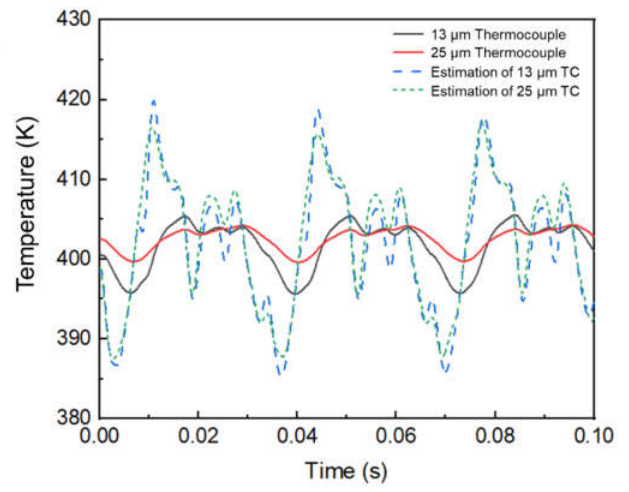
Figure 5. A sample of the comparison of the original and estimated